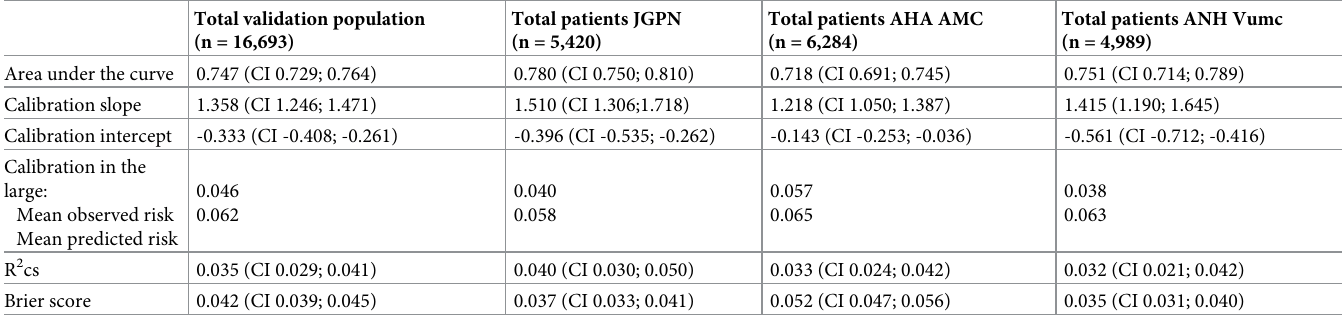
Table 5. Performance temporal